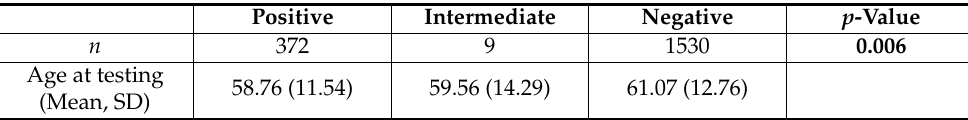
Table 6. Distribution of age at testing across C9orf72 HRE test outcomes.